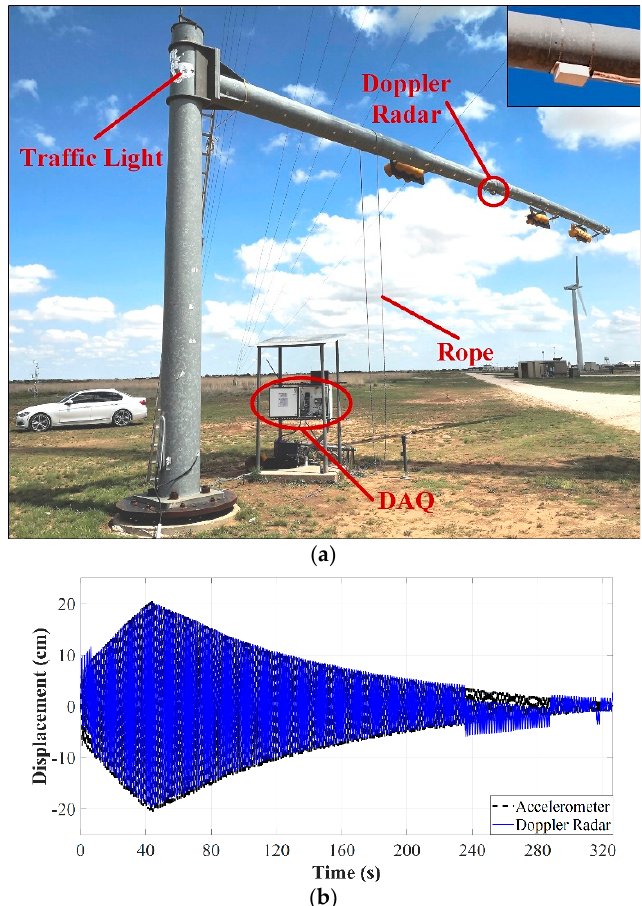
Figure 8. Experimental results for the field SHM of a traffic light structure: ( a ) experimental setup with the radar enclosure shown in the inset; ( b ) demodulated displacement using only arctangent demodulation. Reprinted with Permission from ref. [71]. Copyright 2020 IEEE.